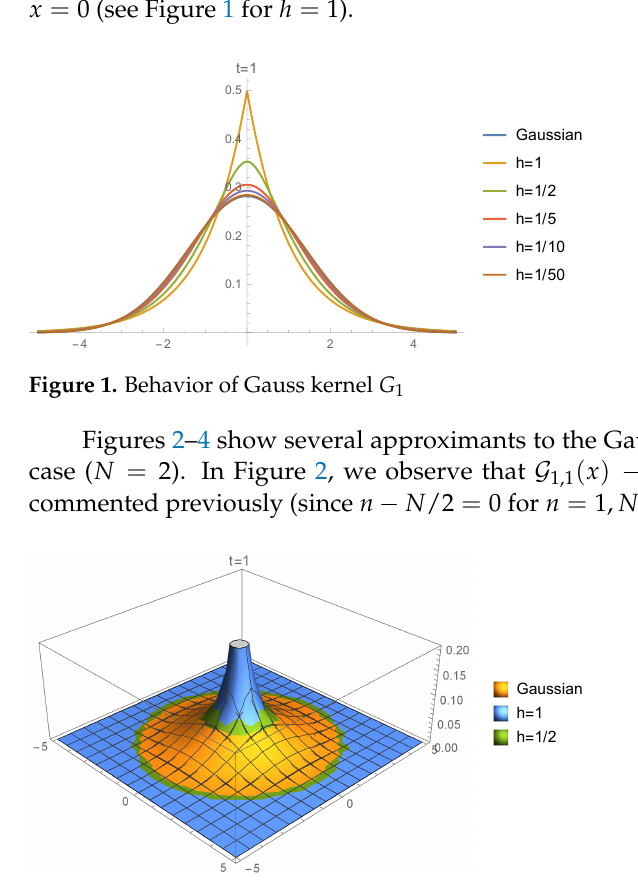
Figure 2. Comparison of G 1,1 with G 1 near x = 0.